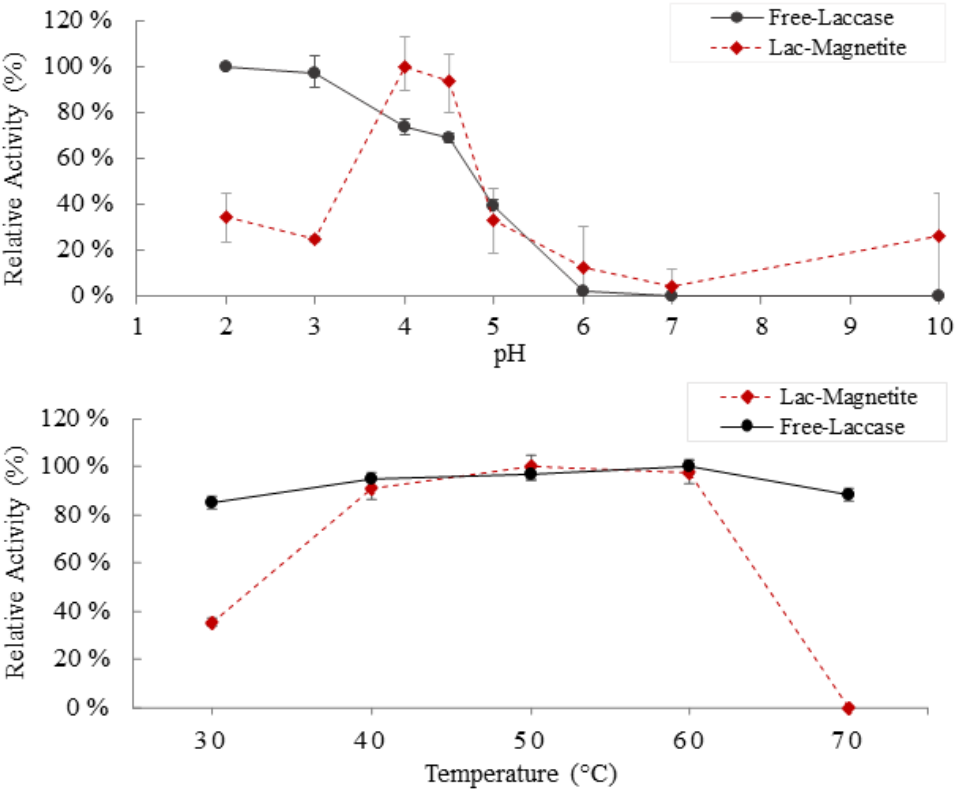
Figure 3. E ff ect of pH and temperature on enzyme activity: ( ● ) free-laccase and ( ♦ ) laccase-magnet- ite.